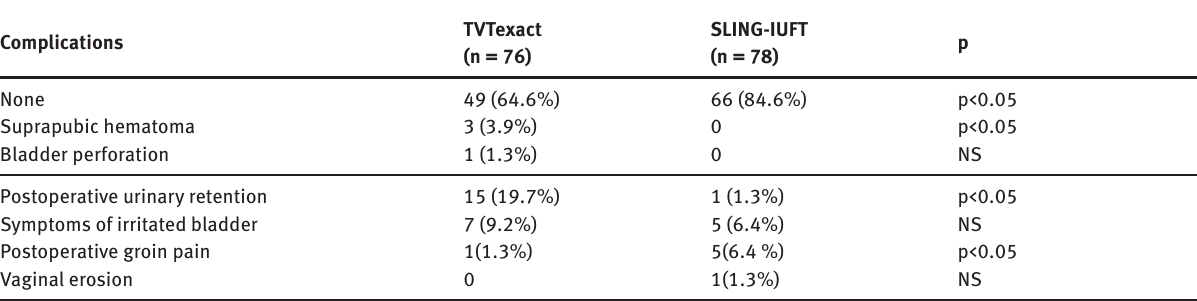
Table 4: Postoperative